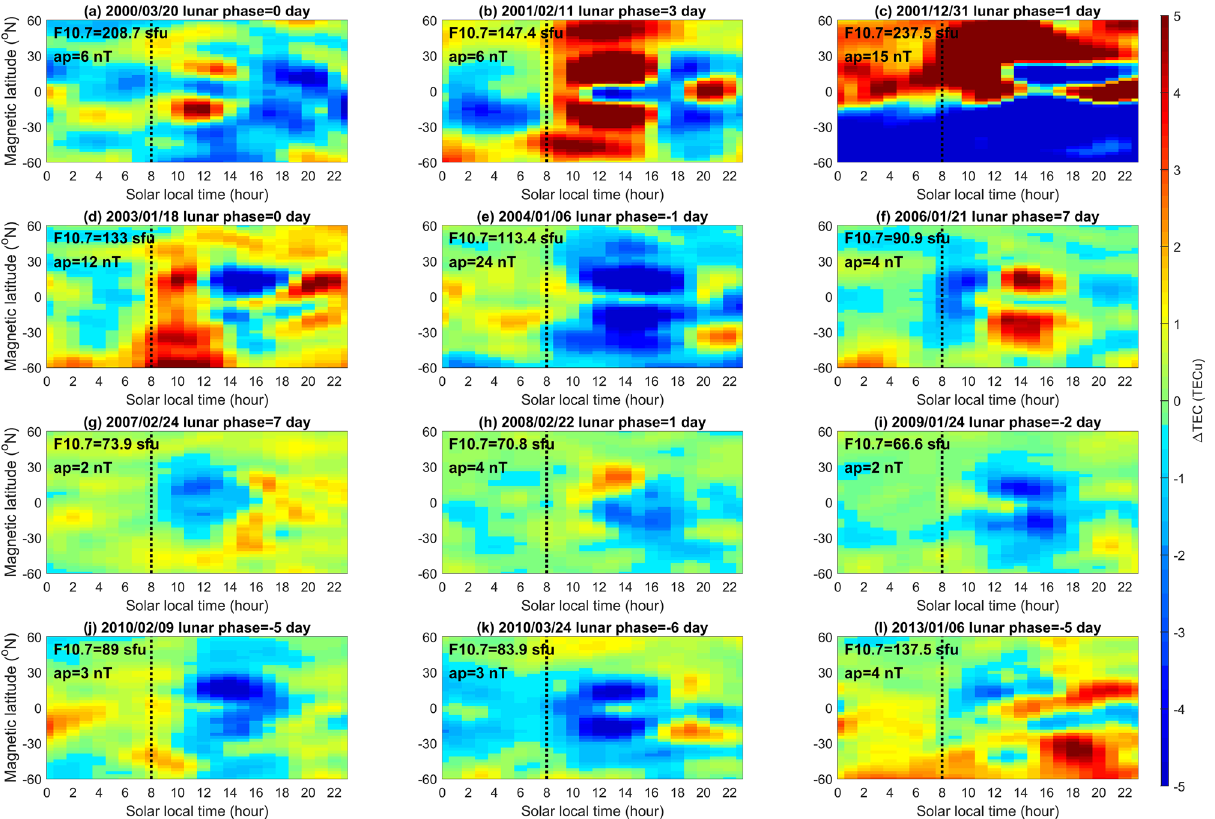
Figure 3. LTT ΔTEC plots of the 12 SSW events of CP07. Dashed black lines denote 08:00 SLT. Daily solar flux and ap index for each SSW event are denoted